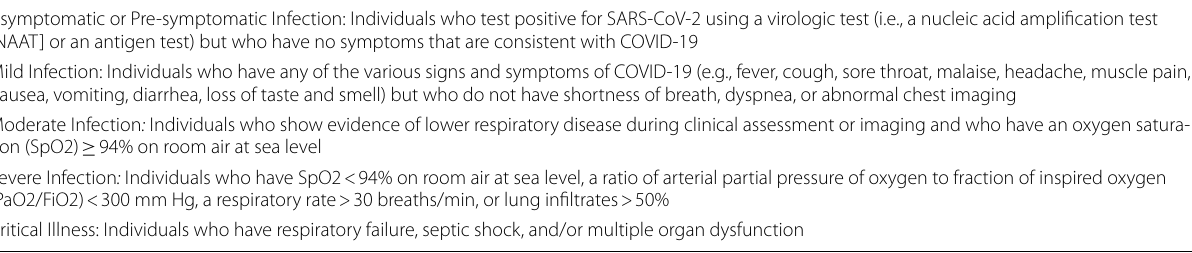
Table 2 The present classification for severity of COVID-19 infection. All cases of this series had a history of mild infection Asymptomatic or Pre-symptomatic Infection: Individuals who test positive for SARS-CoV-2 using a virologic test (i.e., a nucleic acid amplification test [NAAT] or an antigen test) but who have no symptoms that are consistent with COVID-19 Mild Infection: Individuals who have any of the various signs and symptoms of COVID-19 (e.g., fever, cough, sore throat, malaise, headache, muscle pain, nausea, vomiting, diarrhea, loss of taste and smell) but who do not have shortness of breath, dyspnea, or abnormal chest imaging Moderate Infection : Individuals who show evidence of lower respiratory disease during clinical assessment or imaging and who have an oxygen satura- tion (SpO2) 94% on room air at sea level ≥ Severe Infection : Individuals who have SpO2 < 94% on room air at sea level, a ratio of arterial partial pressure of oxygen to fraction of inspired oxygen (PaO2/FiO2) < 300 mm Hg, a respiratory rate > 30 breaths/min, or lung infiltrates > 50% Critical Illness: Individuals who have respiratory failure, septic shock, and/or multiple organ Reference: COVID-19 treatment guidelines https:// www. covid 19tre atmen tguid elines. nih. gov/ (Accessed on 6/21/2022.)